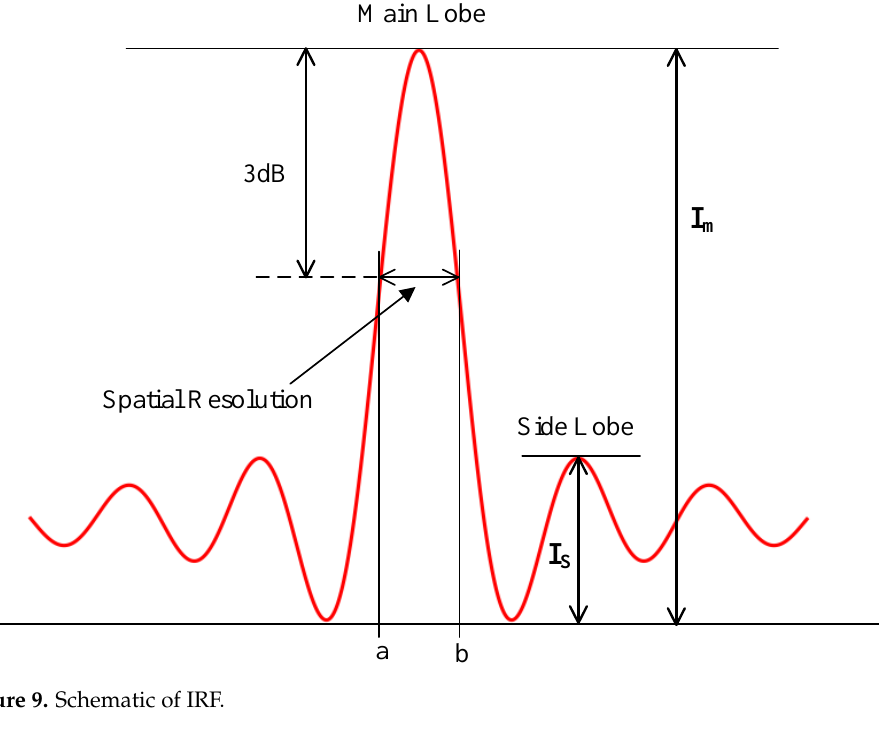
Figure 9. Schematic of IRF.